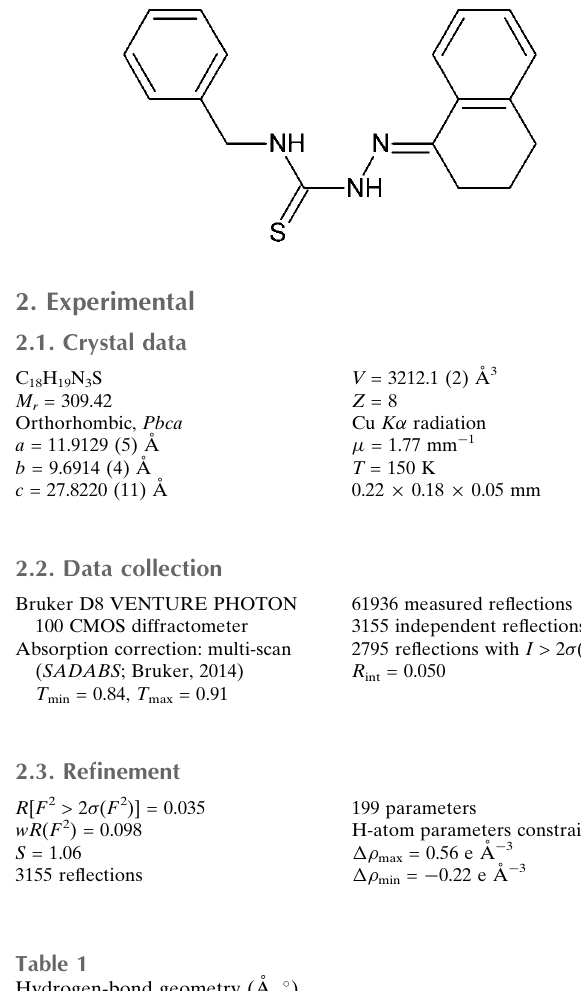
Hydrogen-bond geometry (A˚ , (cid:2)